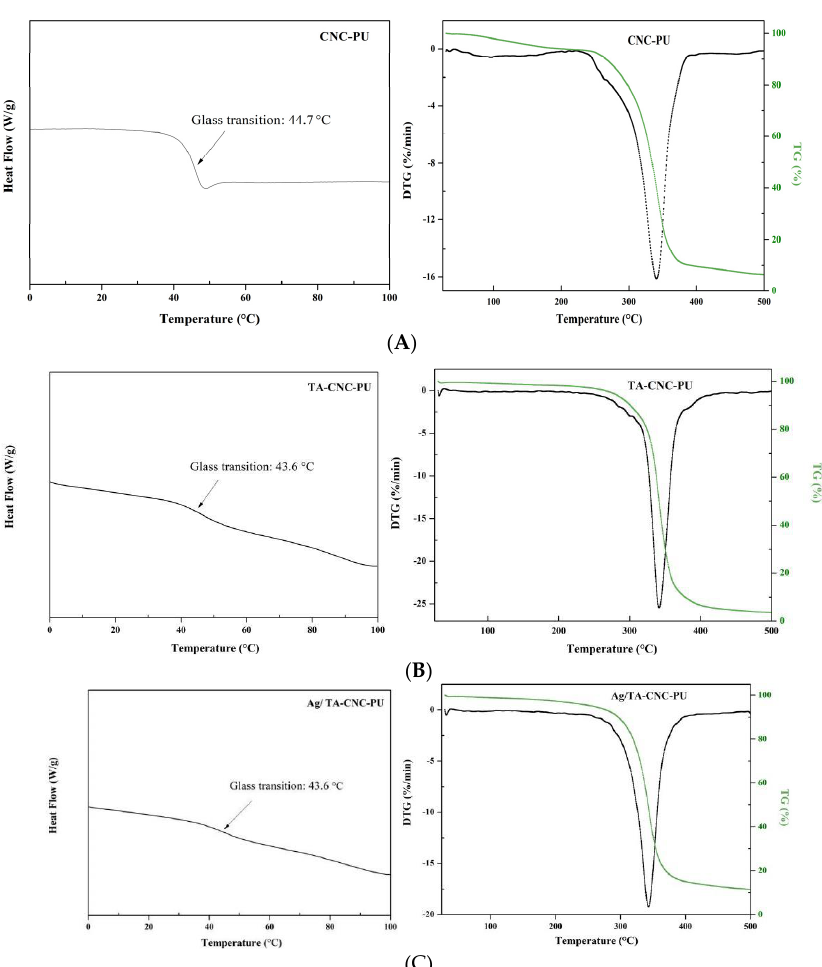
Figure 5. The DSC and TG/DTG curves of CNC-PU ( A ), TA-CNC-PU ( B ) and Ag/TA-CNC-PU ( C